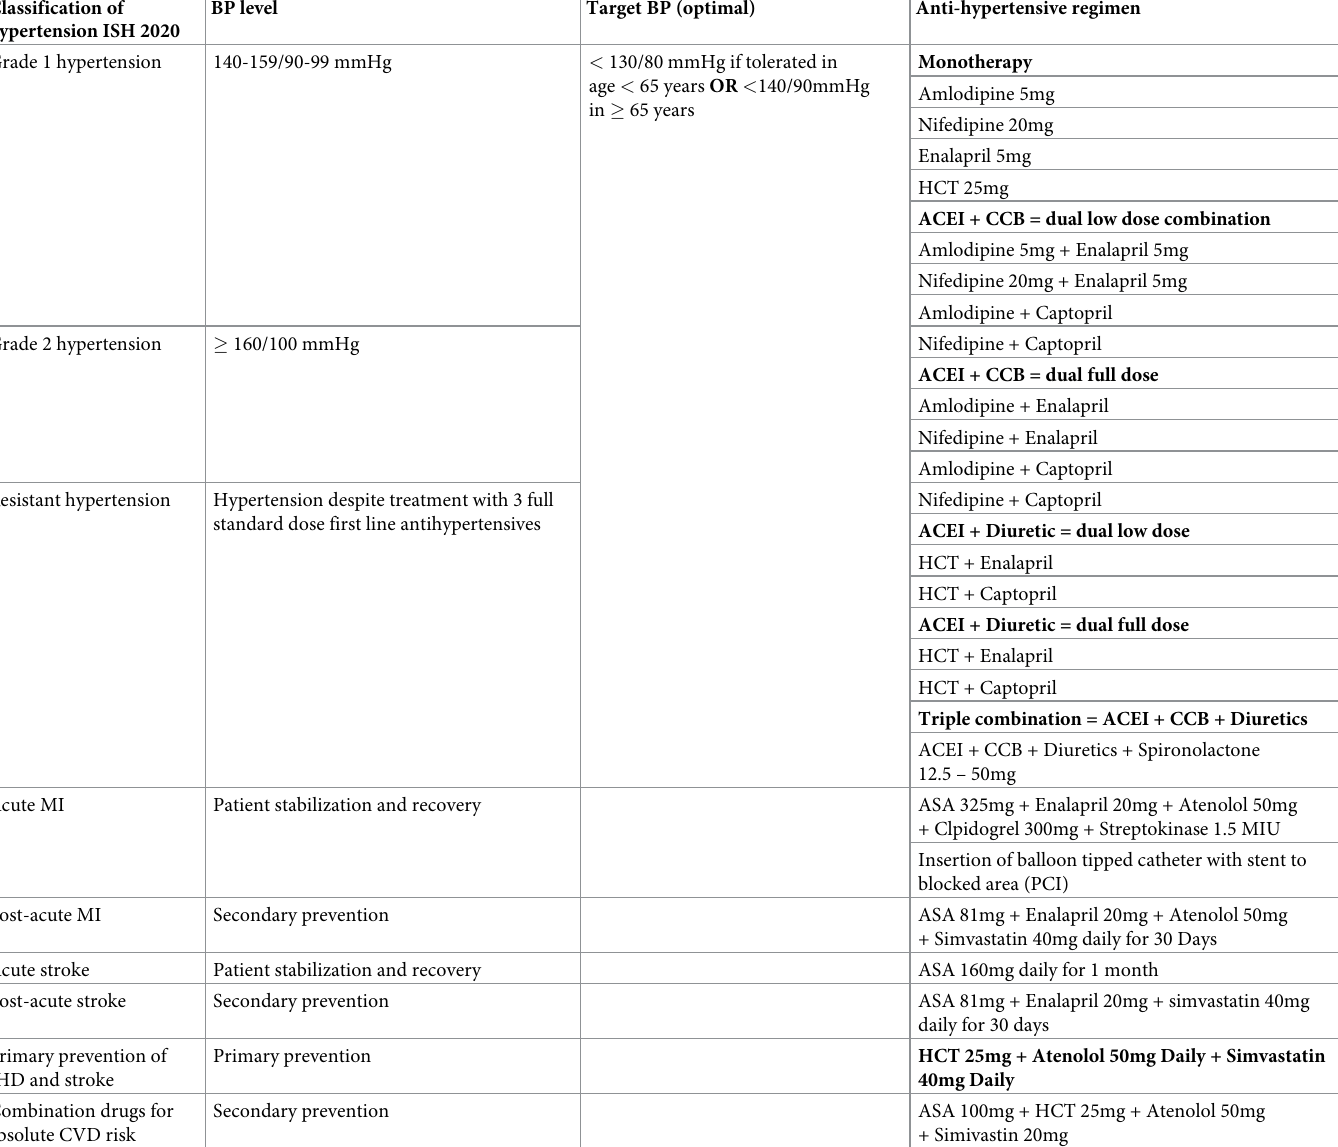
Table 2. Treatment modalities for managing high blood pressure based on ISH 2020 guidelines among adult hypertensive patients in antihypertensive drug public hospitals in Southern Ethiopia (n =